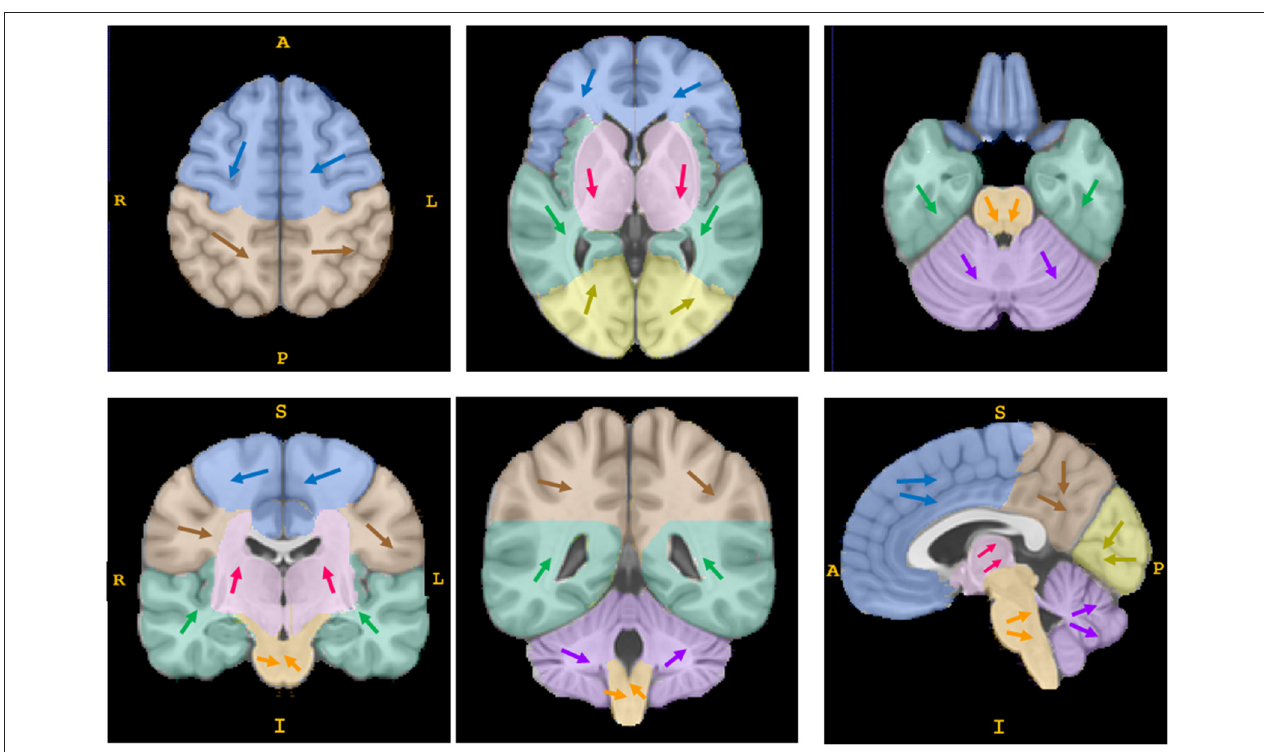
FIGURE 3 | The direction of movement of the geometric center of hematomas. Each arrow of a different color represents the synthesized direction of center movement in a different anatomical region (the frontal lobe is shown in blue, the parietal lobe in brown, the insula and temporal lobe in green, the occipital lobe in yellow, the basal ganglia/thalamus area in pink, the brain stem in orange, and the cerebellum in purple). The direction of center movement in deep supratentorial regions (basal ganglia/thalamus area) and subtentorial regions (brain stem and cerebellum) was in the direction of gravity as patients lay in a supine position; some supratentorial lobar hematomas showed no such pattern. This is a schematic diagram; the details are shown in attachment